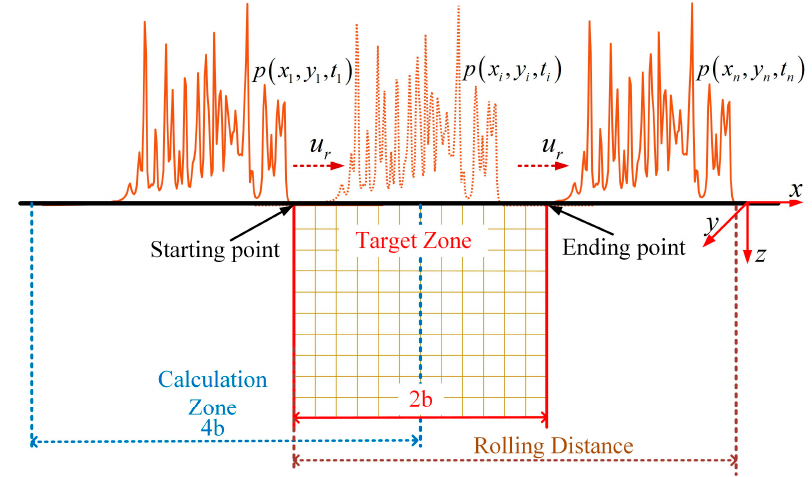
Figure 4. The calculation domain and target zone.